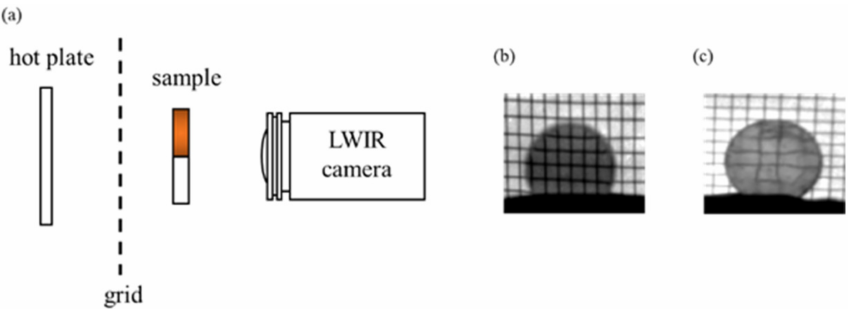
Figure 8. ( a ) Thermal imaging set-up for GRIN lens; ( b ) grid image of the axial GRIN lens; ( c ) under the same conditions, the grid of spherical GRIN lens was significantly